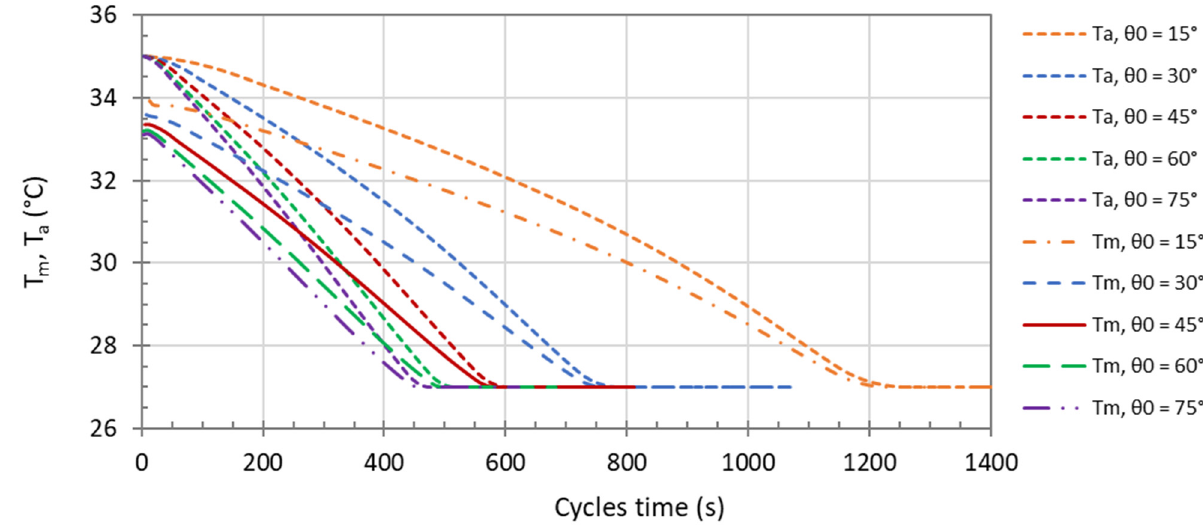
Figure 7. Variation of the average values of air temperatures T m and T a ( ◦ C) with respect to the simulation cycles time, in the region from the room floor up to the level of 1.90 m above floor. The values of the corresponding cooling rates ( ◦ C/min) in time intervals are provided in Table 3 with respect to θ 0 . It is observed that the cooling rates CR m of T m are absolutely lower than CR a of T a . The absolutely lowest value of CR m is − 0.266 ◦ C/min, which